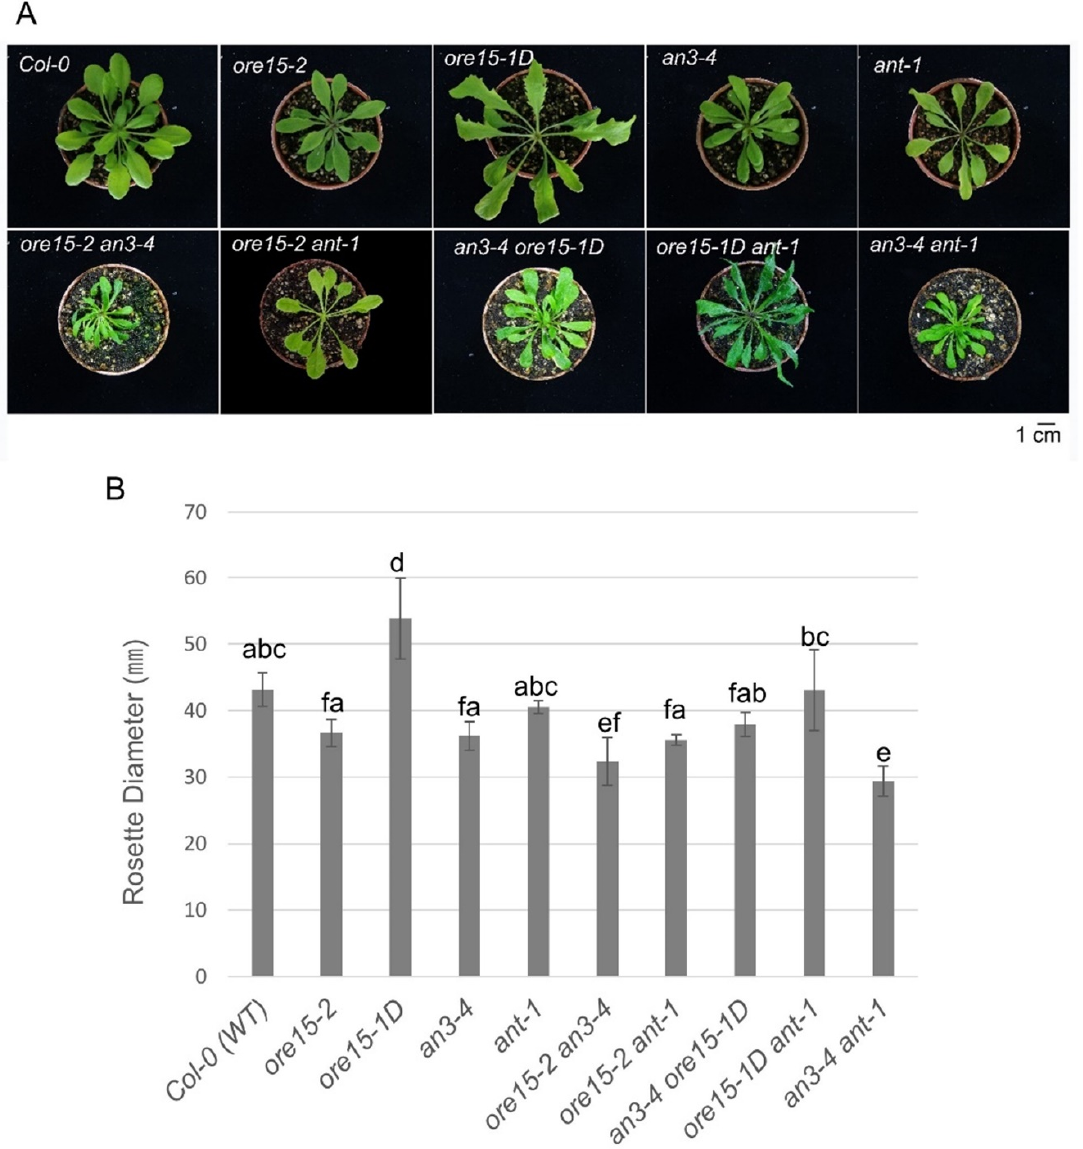
Figure 2. Plant morphology and rosette diameter of the Arabidopsis Columbia-0 (Col-0) wild type (WT), single loss of function (LOF) and gain of function (GOF) mutants. ( A ) Plant phenotypes of the ore15-2 , ore15-1D , an3-4 , ant-1 , and combined double mutants, ore15-2 an3-4 , ore15-2 ant-1 , an3-4 ore15-1D , ore15-1D ant-1 , and an3-4 ant-1 at 35 DAS. ore15-2 (SALK_029507) is a T-DNA insertional mutant and ore15-1D is a dominant mutant isolated from activation tagging lines, in which T-DNA was inserted in the first intron and 3′ UTR of ORE15 , respectively. an3-4 has a large deletion in the AN3 locus and ant-1 has a 22-nucleotide deletion in the second exon of the ANT locus. Scale bar = 1 cm. ( B ) The widest diameter of rosette leaves. Data are means ± standard error (SE) ( n = 5). Means were compared using one-way analysis of variance (ANOVA) followed by Duncan’s multiple range test. Different lowercase letters indicate significantly different means between genotypes.